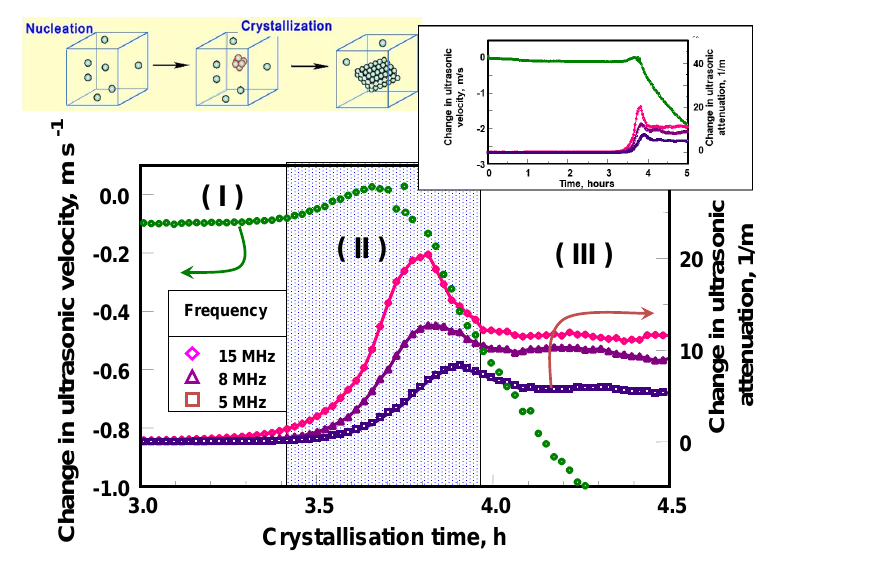
Figure 6. Ultrasonic monitoring of crystallisation of lysozyme. 40mgmL − 1 aqueous solution of lysozyme in 0.1M sodium acetate buffer at pH4.8 and 20 ◦ C. At time zero a precipitating agent was added to 1mL of lysozyme solution in ultrasonic cell of a HR-US 102P ultrasonic spectrometer (Ultrasonic Scientific, Dublin) (Lawrence et al.,